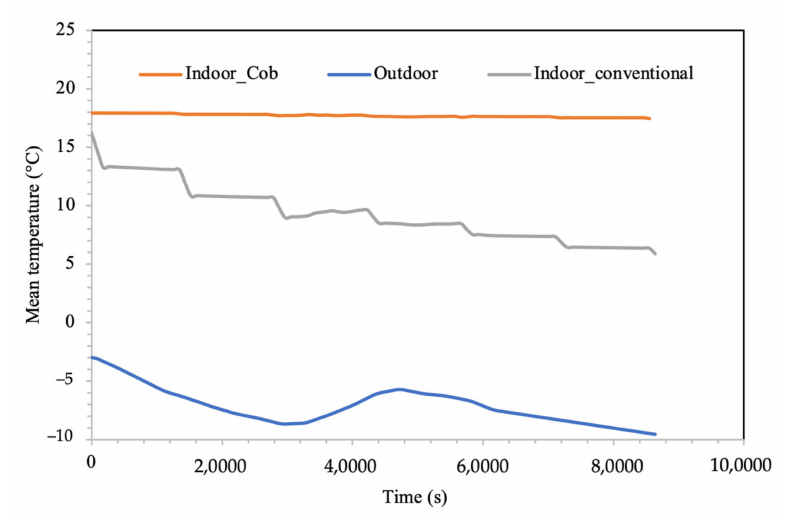
Figure 14. Indoor and outdoor temperature during the coldest day without heating.